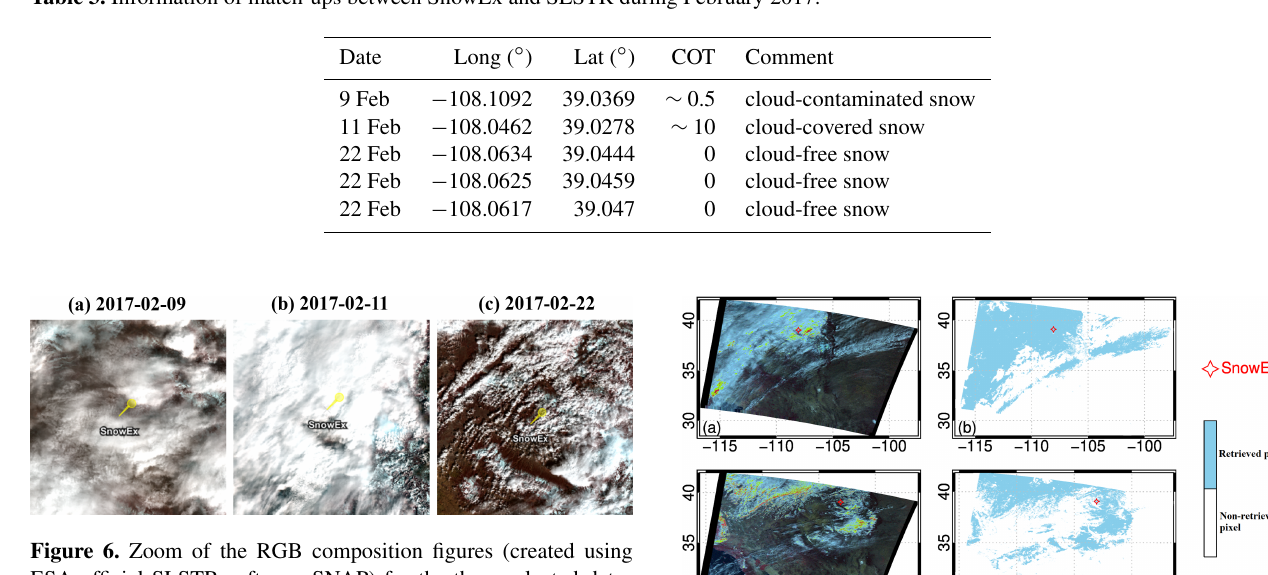
Table 3. Information of match-ups between SnowEx and SLSTR during February 2017.